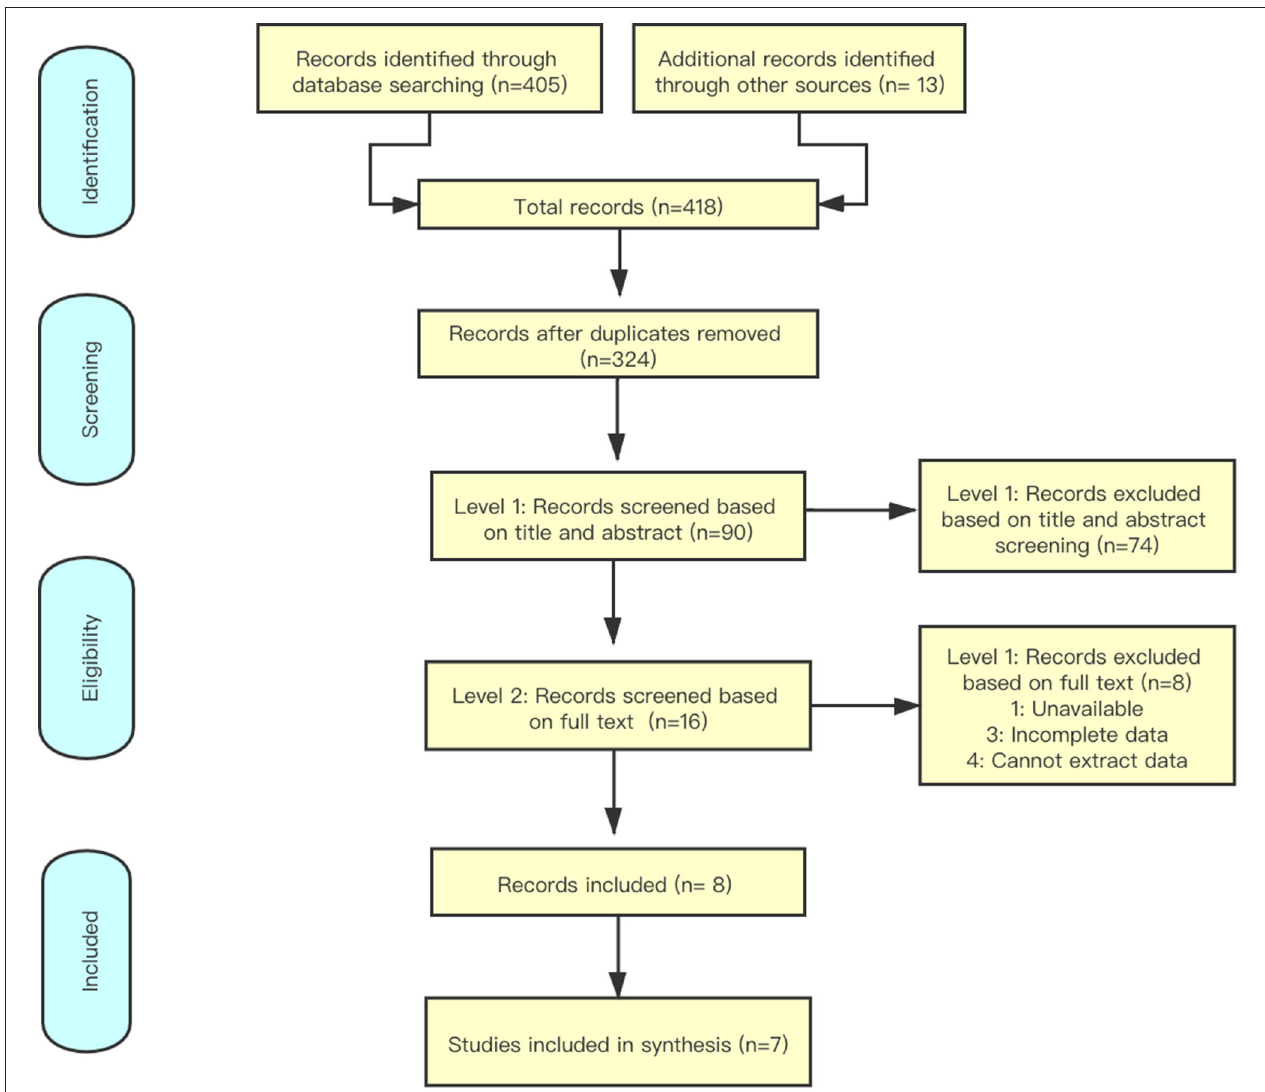
FIGURE 1 | Preferred reporting items for systematic reviews and meta-analyses search